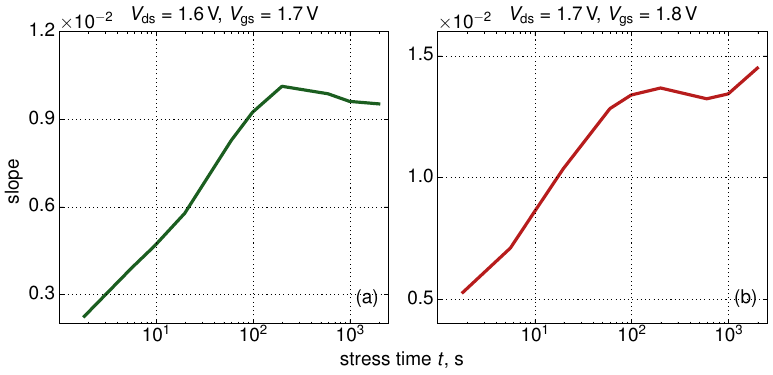
( 0 ) ) dependency as a function of stress time t for V d,lin